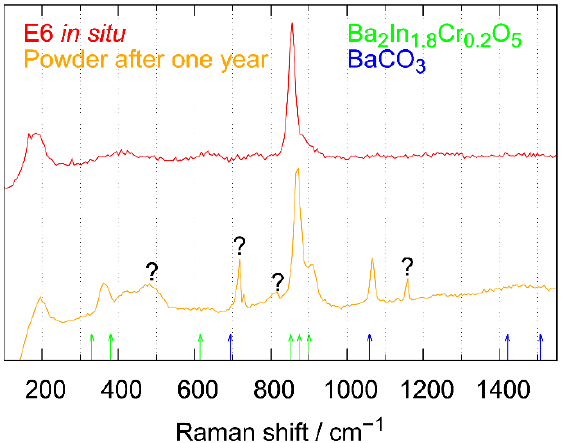
Figure 14. Raman spectra of Ba 2 In 1.8 Cr 0.2 O 5.3 (H 2 O) x : Sample mounted at E6, HZB, Berlin (top); sample investigated in Figure 10 one year after heat treatment in flowing N 2 ( p = 0.15 MPa, p (O 2 ) < 5 ppm, p (H 2 O) < 5 ppm, bottom). Ba 2 In 1.8 Cr 0.2 O 5.3 (H 2 O) x reference data from [3], BaCO 3 reference data from [32], and unassigned peaks marked with “?”.